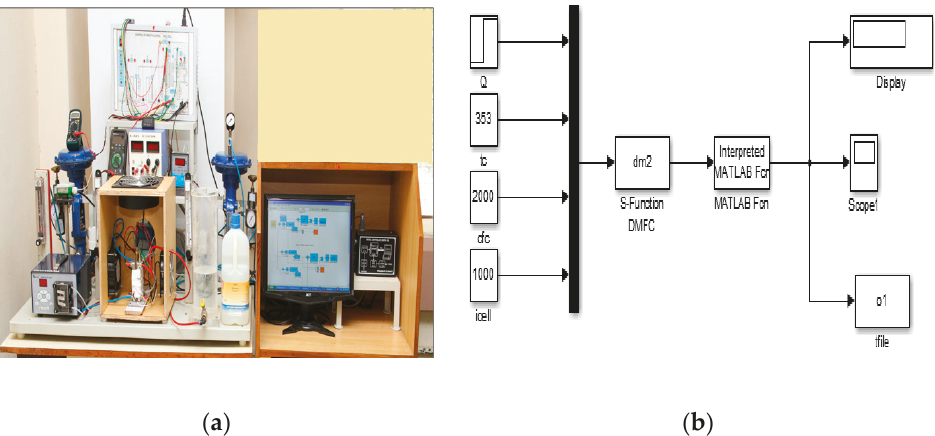
Figure 1. ( a ) Photo Plate of the Direct Methanol Fuel Cell (DMFC) control system. ( b ) Dynamic model of the DMFC.